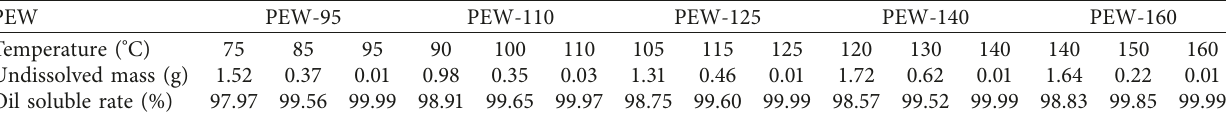
Table 3: The results of oil solubility of polyethylene wax.